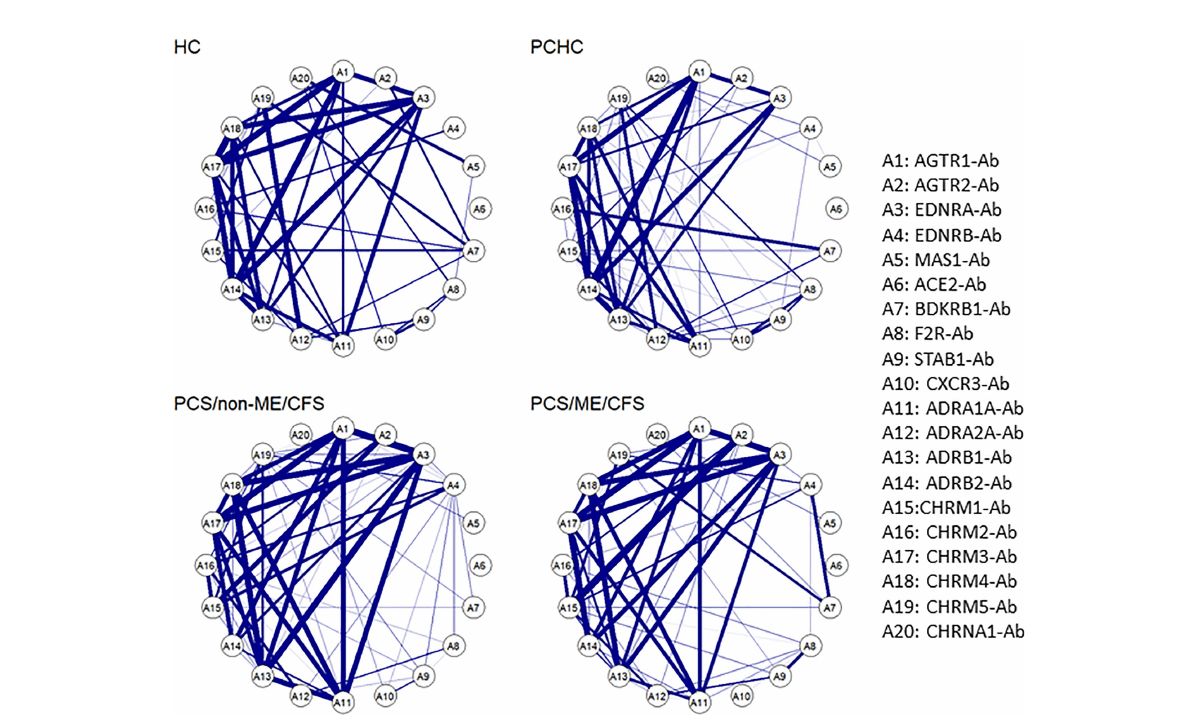
FIGURE 5 Autoantibody correlation signatures associate with post-acute infection outcome. Circular networks based on Spearman ’ s rank correlation for the level of the 20 autoantibodies (-Ab) in post COVID syndrome (PCS) patients with and without ME/CFS and healthy controls post or without COVID-19 history (PCHC or HC). There is a list with the abbreviations and the Abs names by the right side of the plot. Correlations greater than 0.6 are represented by the blue edges, and thicker edges imply greater